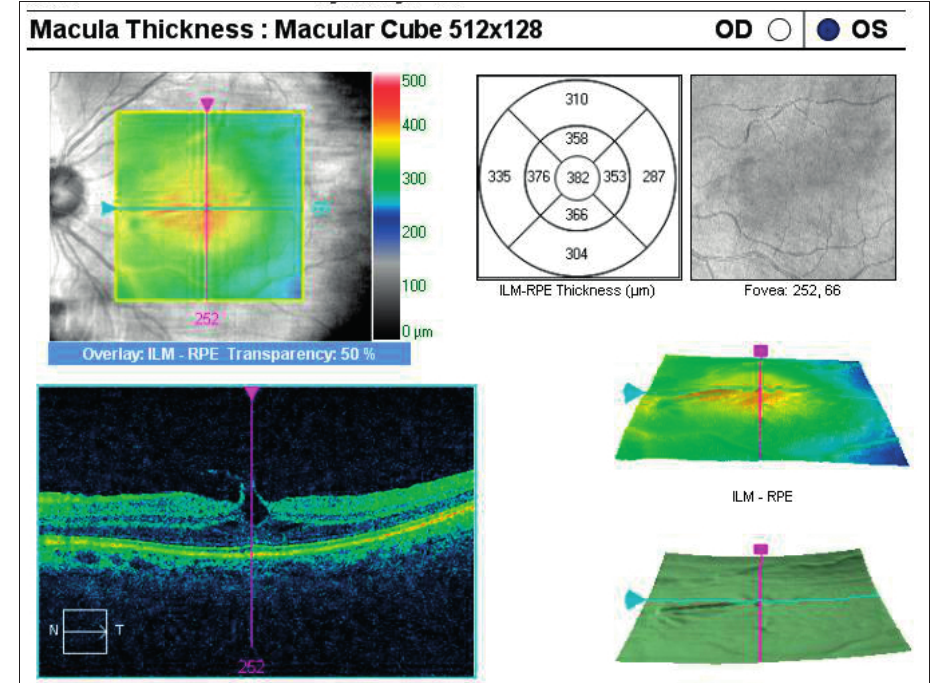
Fig. 5. Improvement of the state without treatment, focal vitreomacular